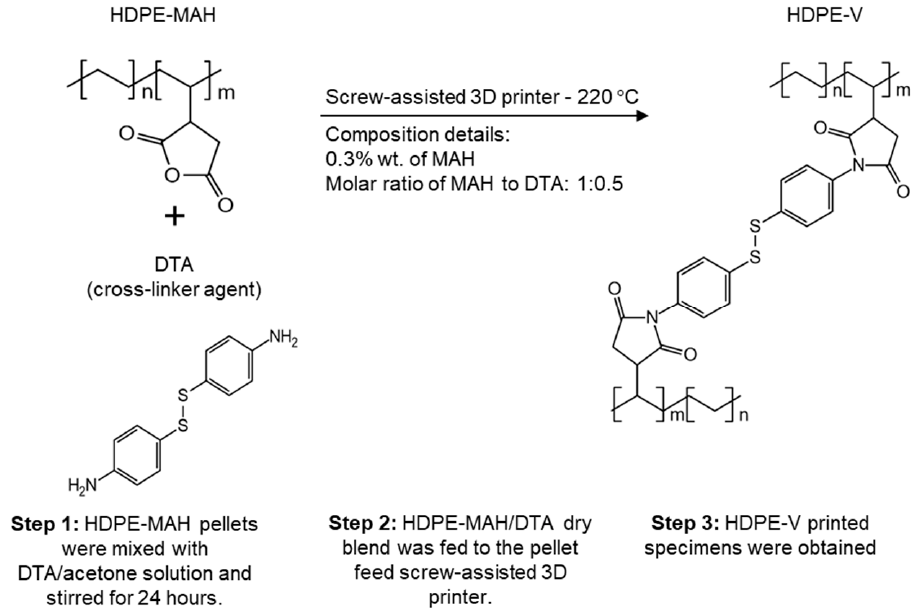
Figure 1. Graphical representation of the protocol used to produce HDPE-V using ME-AM.